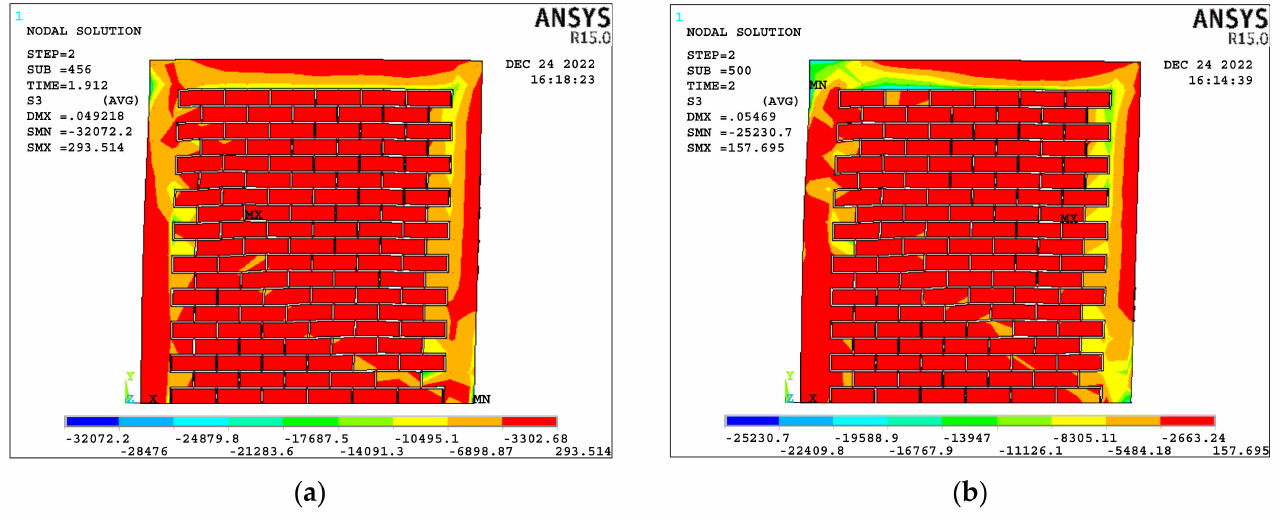
Figure 17. Contour plots of damaged shape ( a ) OPC-CM ( b )